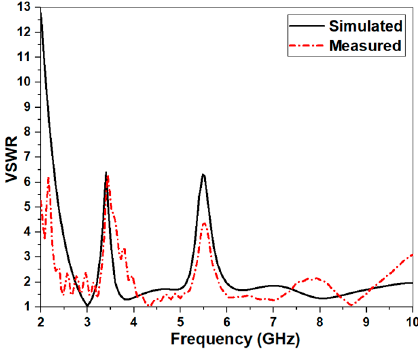
Figure 6. VSWR for the dual-band-notched antenna.